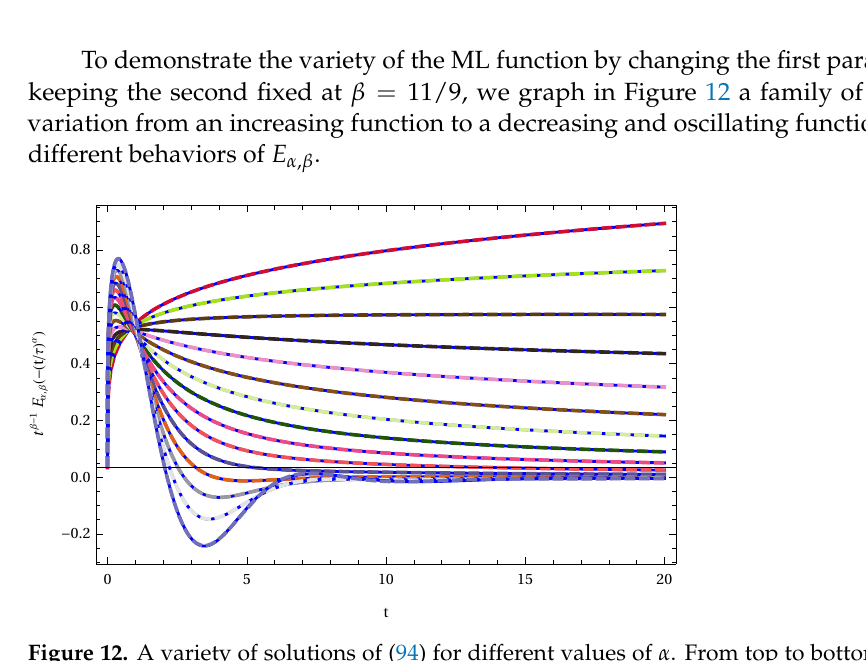
Figure 12. A variety of solutions of (94) for different values of α . From top to bottom on the right end of the graph the α values vary between 0.1 and 1.5 in steps of 0.1 with β = 11/9. The solid line represents the SG inverse Laplace result, while the overlaid dashed line is the Mathematica implementation of t β − 1 E α , β ( − ( t / τ ) α ) . Parameters are χ 0 = 1, τ = 1, and N = 96.